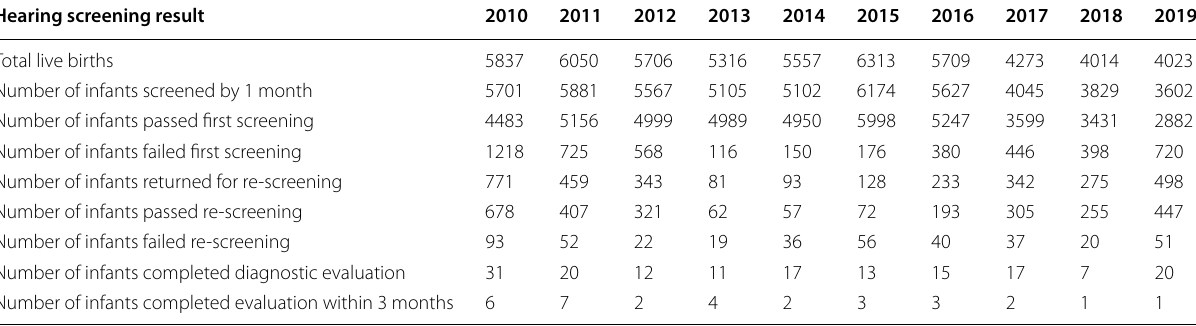
Table 2 Summary of hearing screening results from 2010 to 2019